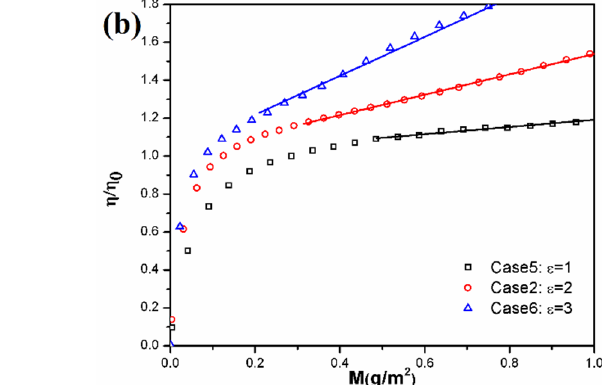
Figure 9. Dynamic changes in slope (λ) with different aspect ratios (with error bars). Figure 8. ( a ) Logarithmic scaling of the normalized pressure drop and ( b ) dynamic changes in the normalized capture efficiency with different aspect ratios. Table 3. Fitting parameters of the simulation cases.